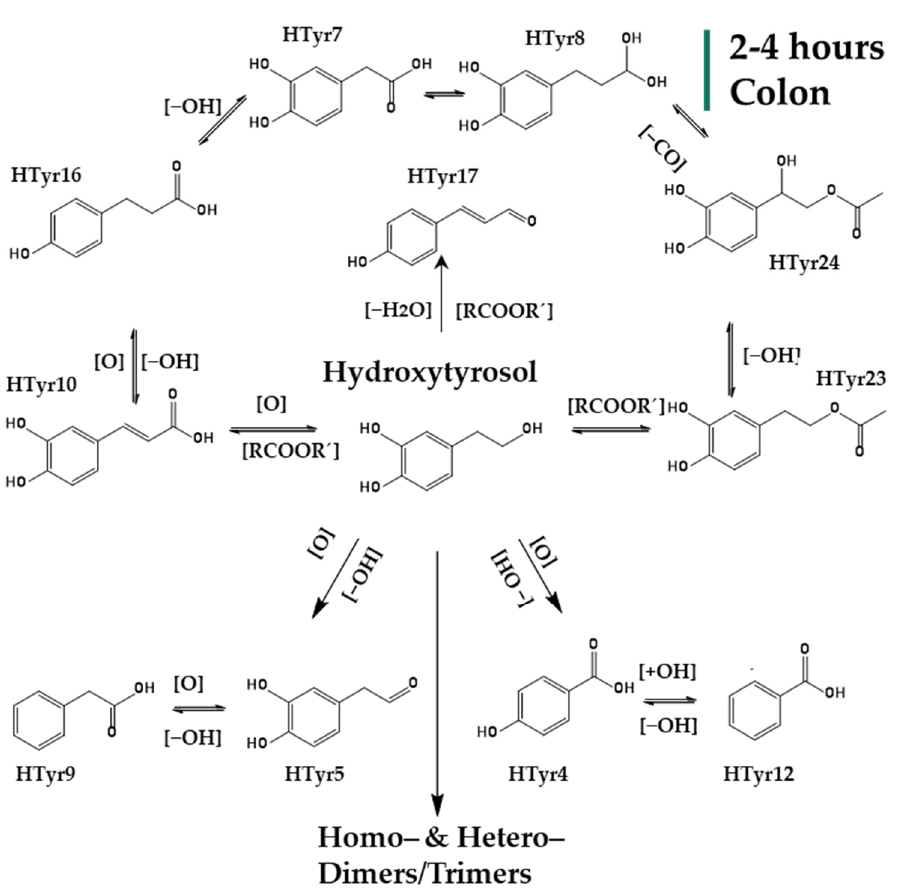
Figure 3. Suggested metabolism pathway of HTyr exposed for 2 to 4 h at colonic conditions (small intestine retentate, fecal slurry, pH: 5.8, anaerobic conditions, T = 37 °C). Particularly in the gastric phase, oxidation, dehydroxylation, and esterification re- actions mainly occurred. HTyr, as a primary alcohol in a strong acidic environment.,